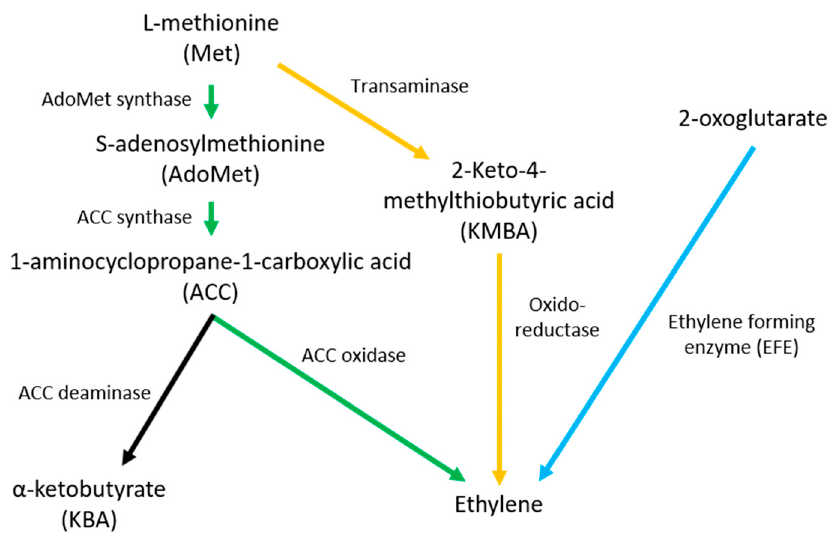
Figure 1. Ethylene biosynthetic pathways; the ACC pathway is shown in green, KMBA pathway in orange and oxoglutarate pathway in blue.